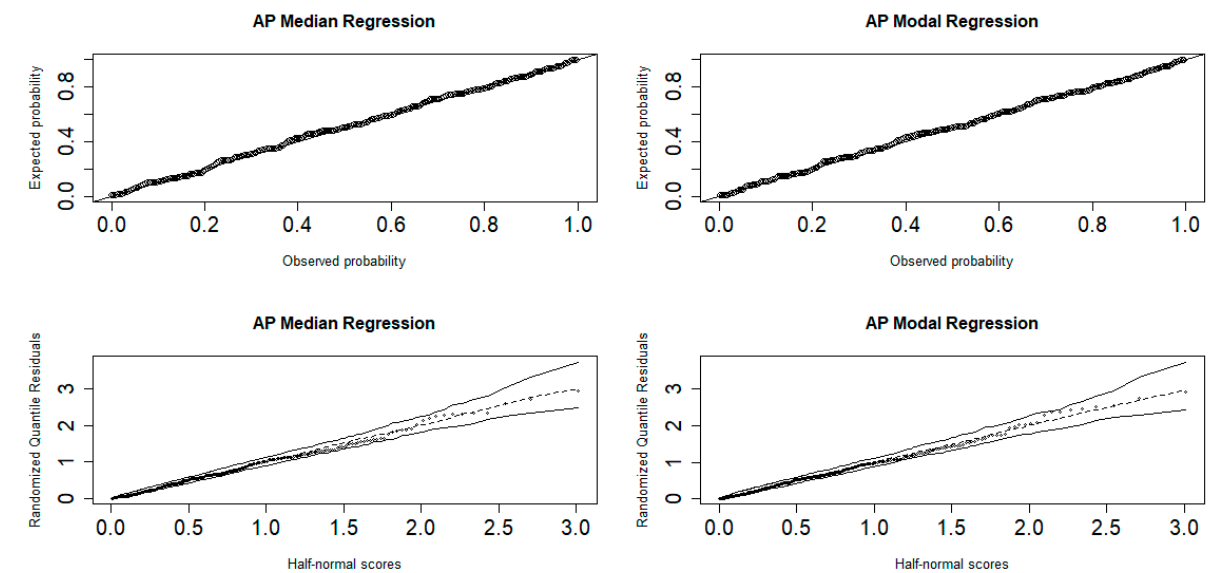
Figure 14. P-P ( top ) and half-normal ( bottom ) plots of the randomized quantile residuals. The P-P and quantile-quantile (Q-Q) plots with simulated envelopes of the Cox–Snell residuals shown in Figure 15 again affirm that the fitted models are adequate.